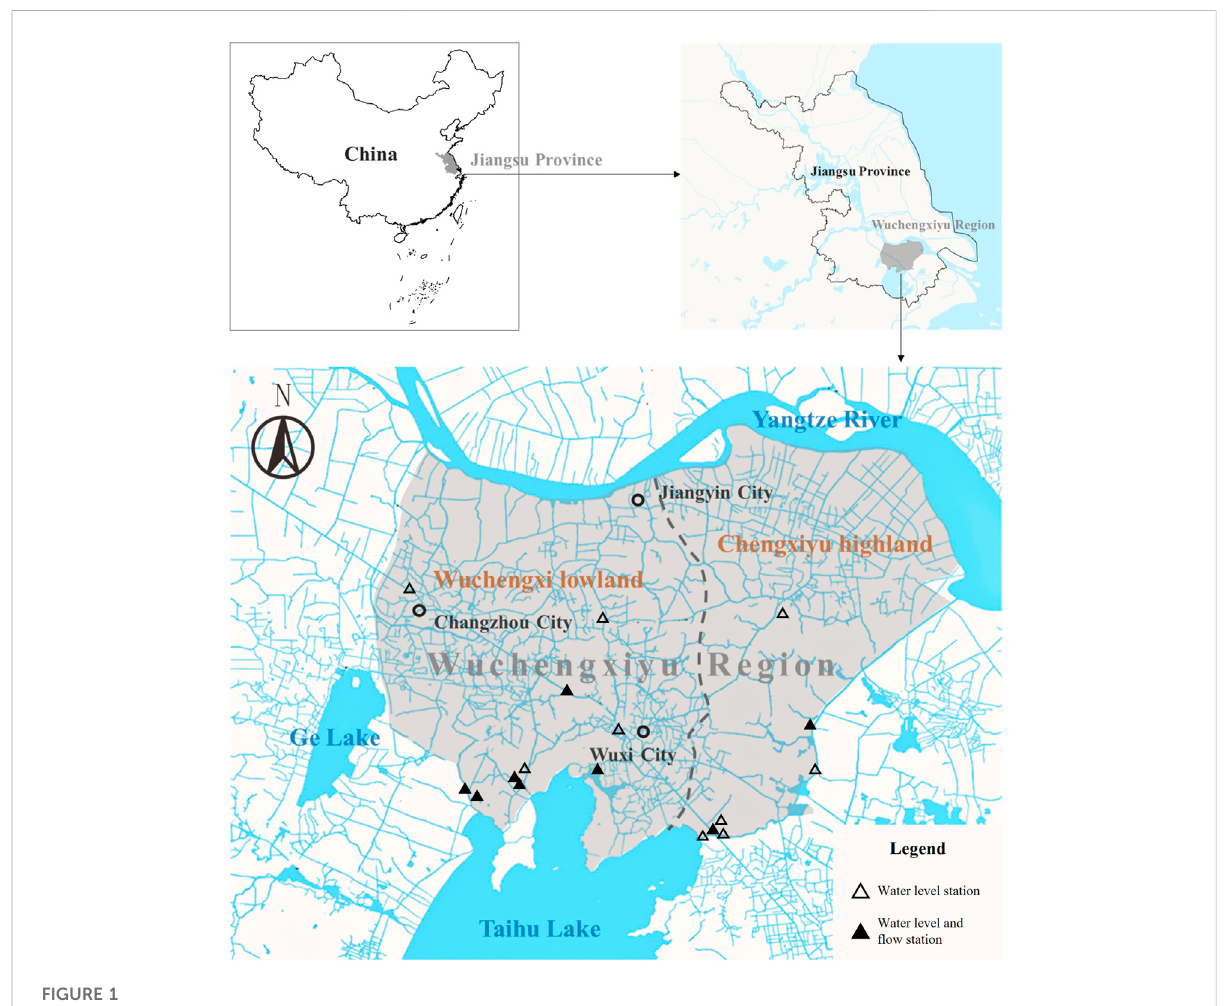
FIGURE 1 Location of the Wuchengxiyu